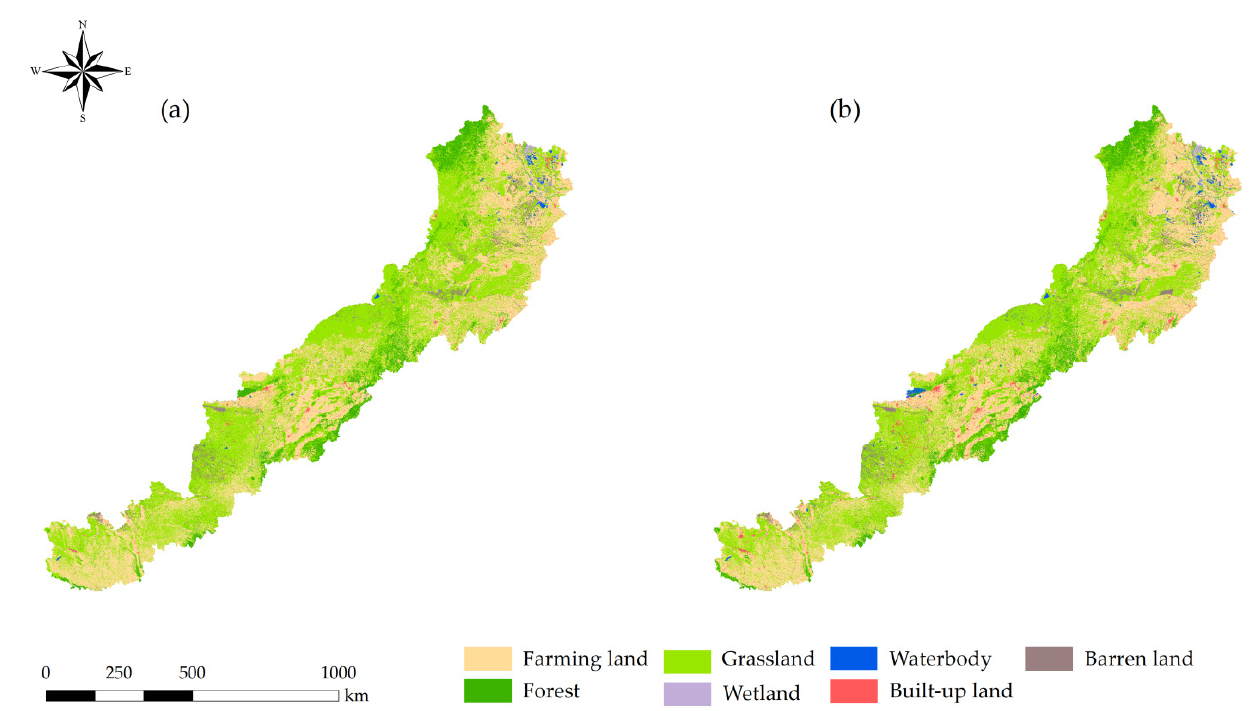
Figure 3. Land-use change in the past: ( a ) 2010; ( b ) 2020.